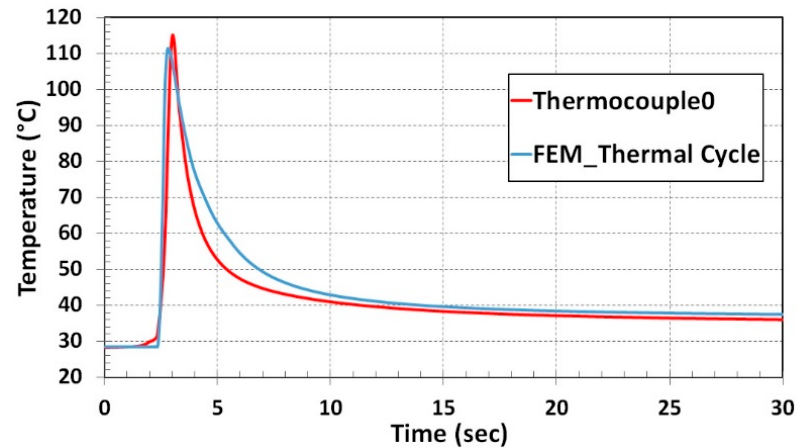
Figure 13. Numerical result and experiment temperature comparison for thermal cycle heat input method.